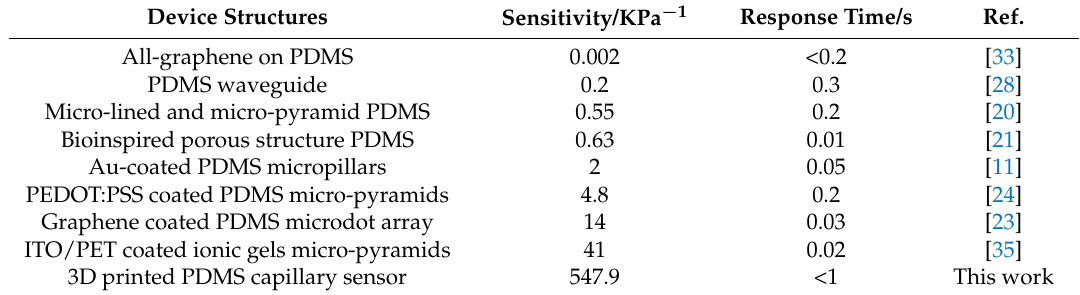
Table 1. Sensitivities of PDMS-based pressure sensors.